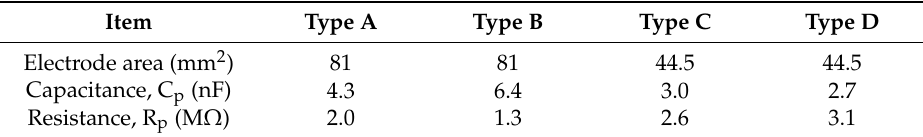
Table 3. Impedance measurement for the PZT cells with various structures.